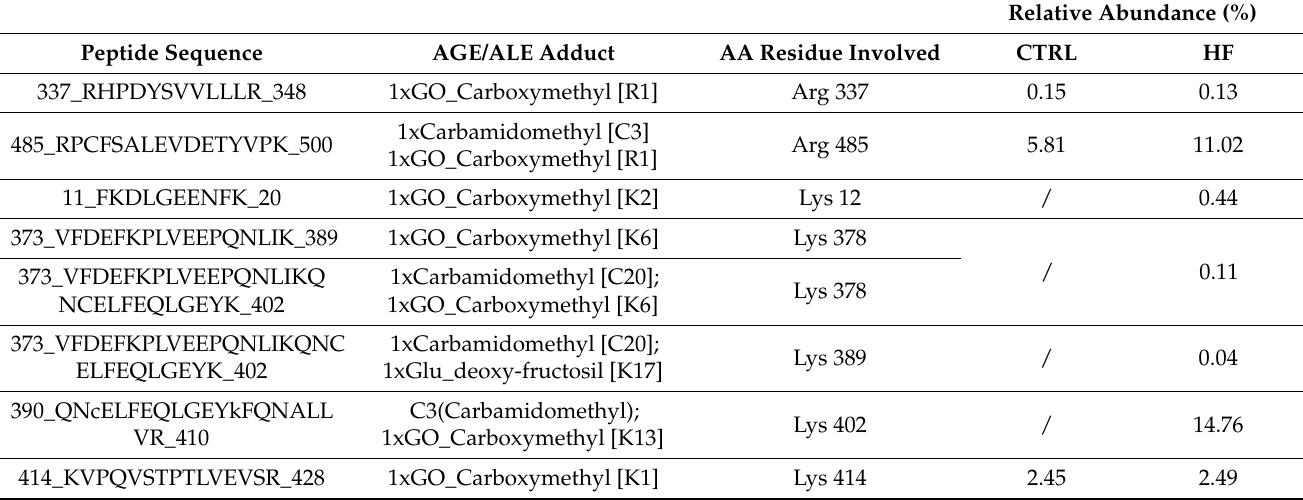
Relative Abundance (%)